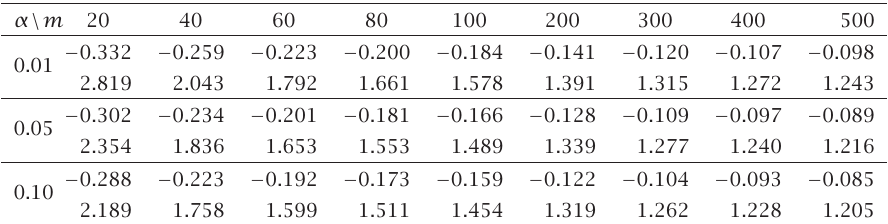
Table 2.1 . The values of a and b for given m and α (the upper entry is for a and the lower entry is for b